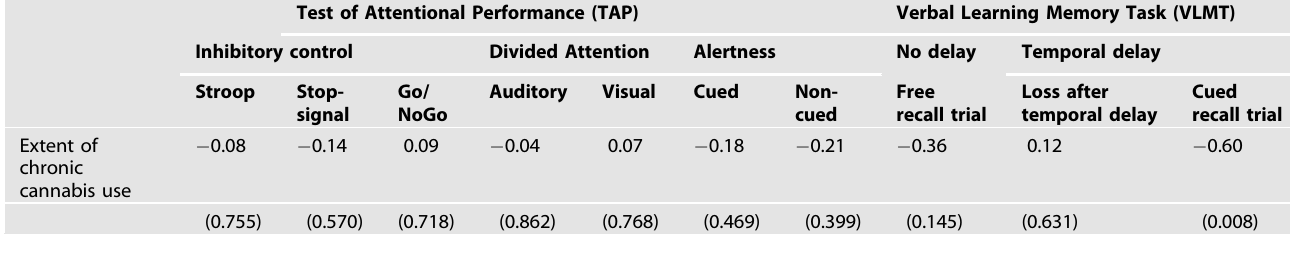
Table 4. Pearson Correlations r ( p -value) between self-reported cannabis use and cognitive tasks.